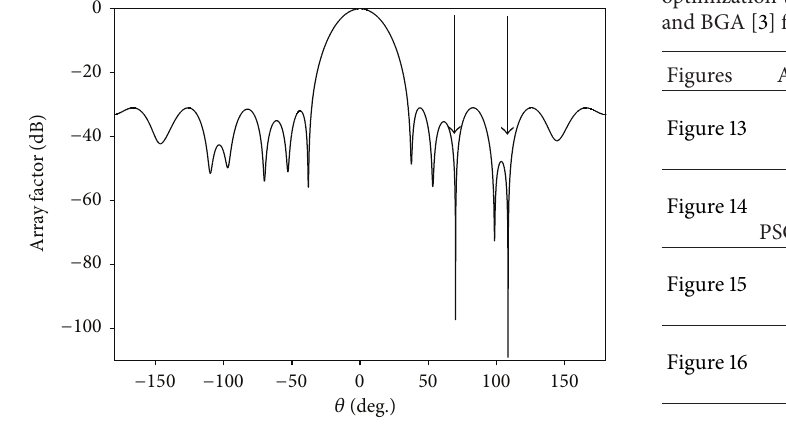
Figure 19: Radiation pattern obtained by amplitude-only control with double imposed null at 70 ∘ and 108 ∘ .